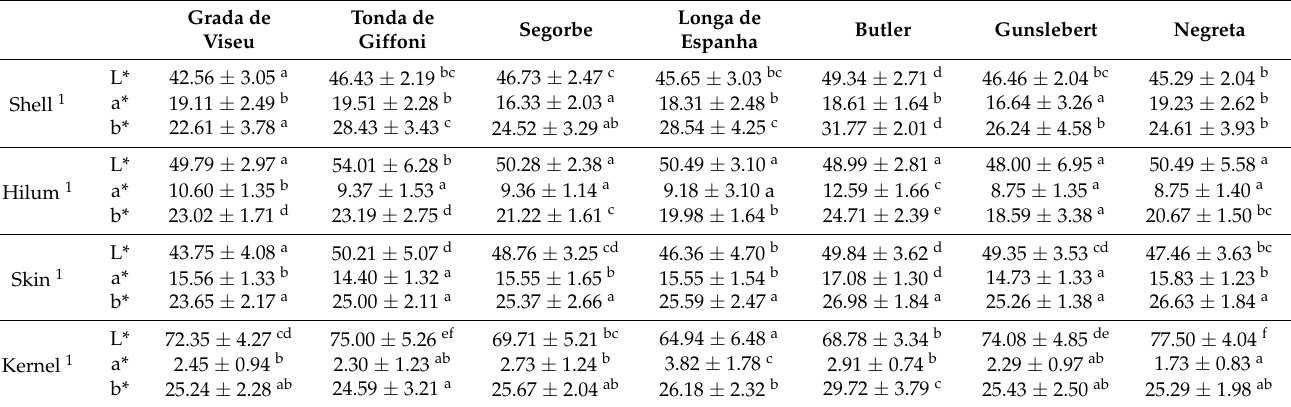
Table 4. Colour coordinates (mean ± standard